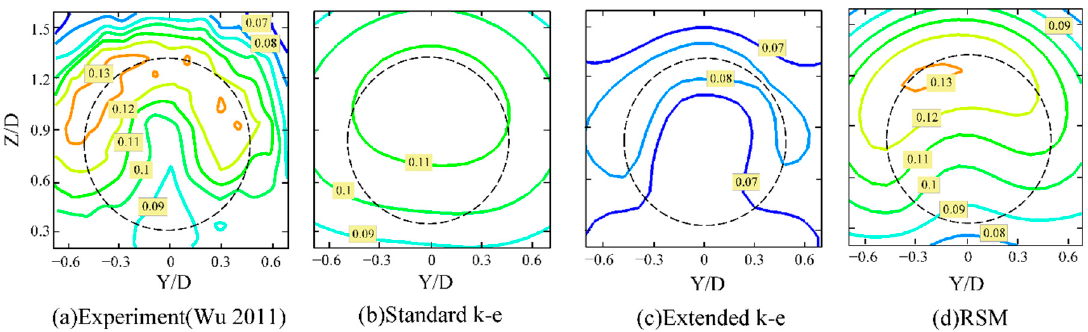
Figure 12. Contours of stream ‐ wise turbulence intensity at 5 D downstream, ( a ) experiment data (obtained from Wu [40]); ( b ) standard k ‐ε model results; ( c ) extended k ‐ε model results; ( d ) RSM results.